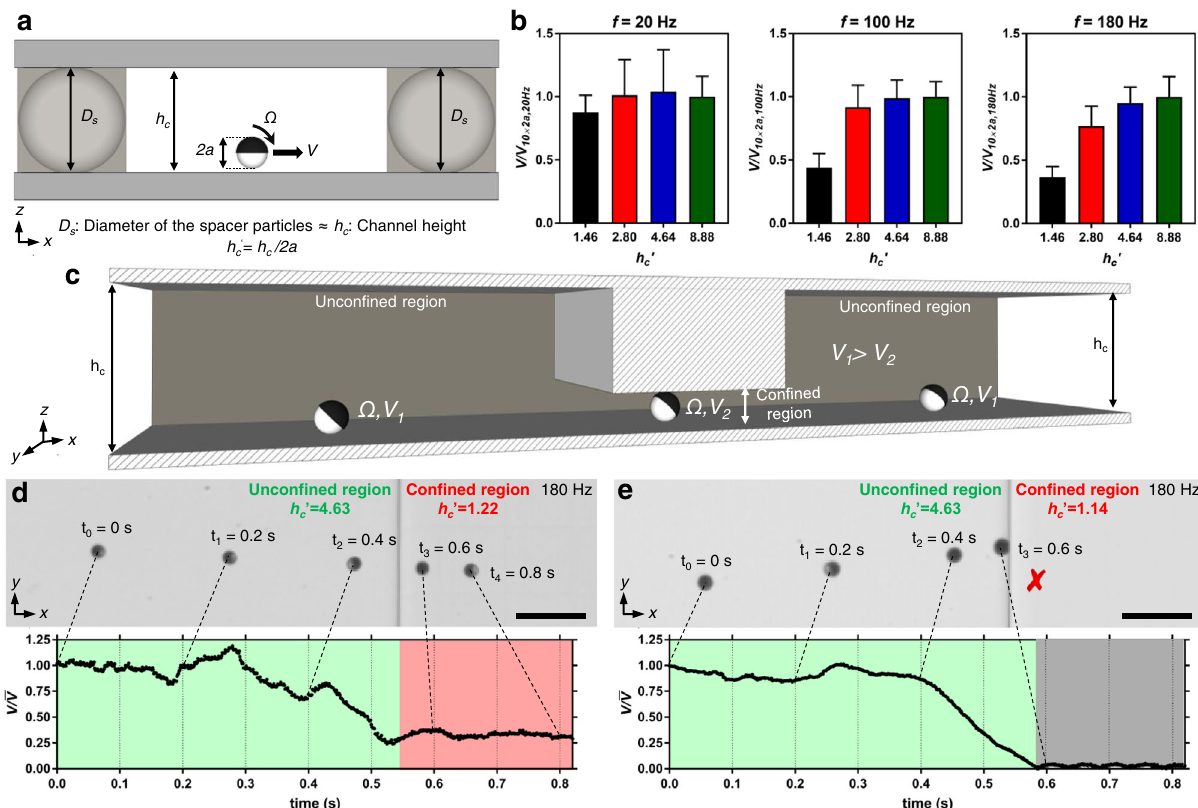
Fig. 2 | The speed of microrollers dramatically decreases in con fi ned channel experiments. a The microrollers were actuated in vertically con fi ned micro- channels composed of spacer particles, where the spacer particles ’ diameter (D s ) de fi ned the channelheight ( h c ), sandwiched betweentwo cover glasses. b Effect of theverticalcon fi nementforfourdifferentcon fi gurations( h c ′ =1.46,2.80,4.64,and 8.88) at f =20, 100 and 180Hz actuation frequencies at10mT fi eld amplitude. The translational velocities ( V ) were normalized to the highest translational velocity of individual frequency groups, the least con fi ned case ( h c ′ =8.88). The con fi nement effectwasbarelyvisibleforthelowestactuation,20Hz,whiletheeffectwassevere at 180Hz. The error bars show the standard deviation of the mean. c Schematic of